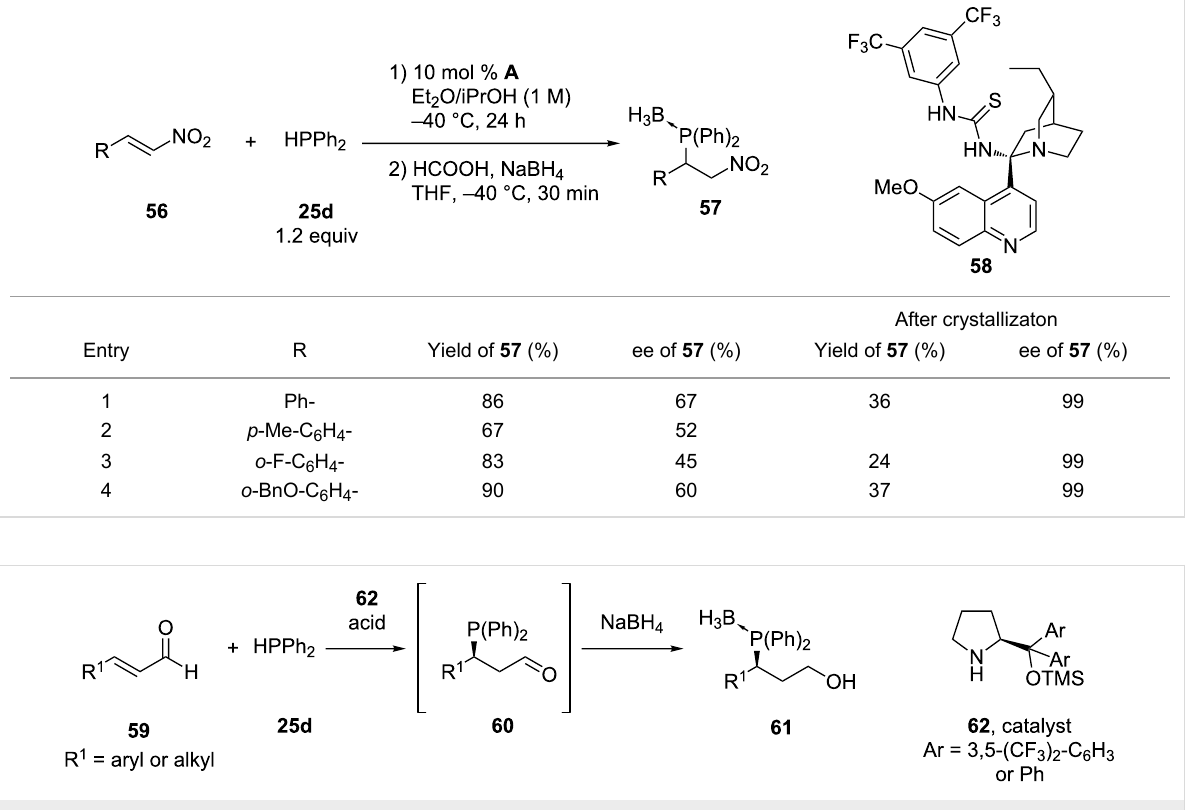
Scheme 16: Organocatalytic asymmetric hydrophosphination of α , β -unsaturated aldehydes 59